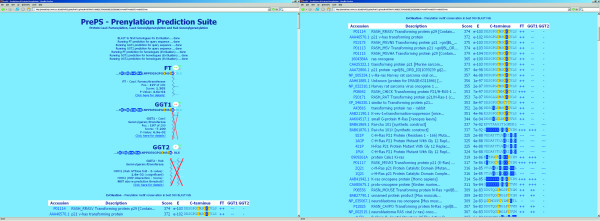
Screenshot of the output provided by the PrePS server [39]. On the left is the prediction result for the query protein H-Ras (GenBank P01112) and the three prenylating enzymes. On the right, is shown the carboxy-terminal alignment and PrePS predictions of homologs of the query protein for evaluation of evolutionary motif conservation. Note that H-Ras is predicted to be prenylated only by FT, whereas the homologs K-Ras and N-Ras can also be prenylated by GGT1.